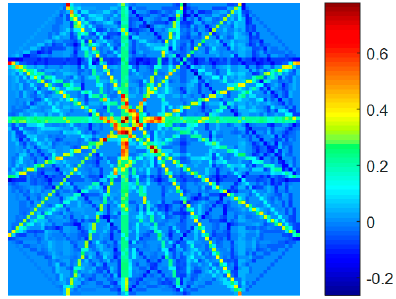
Figure 12. The original tomographic imaging.